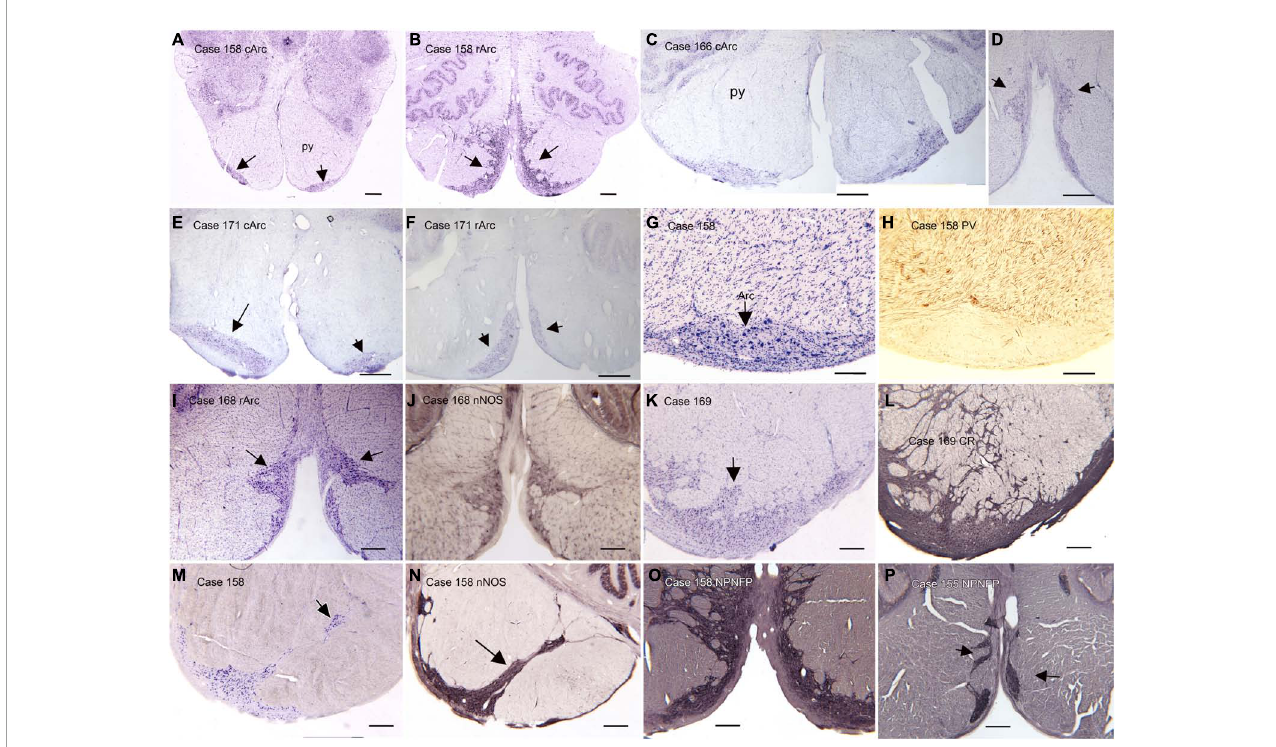
FIGURE2 The Arcuate nucleus (Arc) of the medulla. There are two distinct subdivisions, the caudal (cArc) and rostral (rArc) subdivisions. (A) The cArc (arrows) on a CV-stained section from Case 158. The cArc is ventrolateral to the pyramidal tracts (py) at the ventral surface of the brainstem. (B) The rArc (arrows) in Case 158. The rArc is ventromedial to the py and extends up the midline. The section in panel (B) is 14 mm rostral to the one in panel (A) . Note the left-right asymmetry in panels (A,B) . (C,D) cArc and rArc in Case 183. (E) cArc (arrows) in Case 171. In this case, the Arc on the left is dorsal to the surface of the brainstem, embedded in the py. (F) rArc in Case 171 on a section 10 mm rostral to the one in panel (E) . (G) The Arc on a CV-stained section adjacent to a section (H) immunostained for parvalbumin (PV). (I) The Arc on a CV-stained section adjacent to a section (J) immunostained for nitric oxide synthase (nNOS). (K) The Arc on a CV-stained section adjacent to a section (L) immunostained for calretinin (CR). Arc neurons and processes express CR. (M) The Arc on a CV-stained section. (N) Adjacent section immunostained for nNOS. In this case the Arc extends well into the py. (O,P) Sections from two different cases immunostained for non-phosphorylated neurofilament protein (NPNFP). Neurons and processes express NPNFP, and the Arc stands out from surrounding white matter of the py. Scale bars: (A–F) = 1 mm; (I–P) = 500 µ m; (G,H) = 250 µ m.